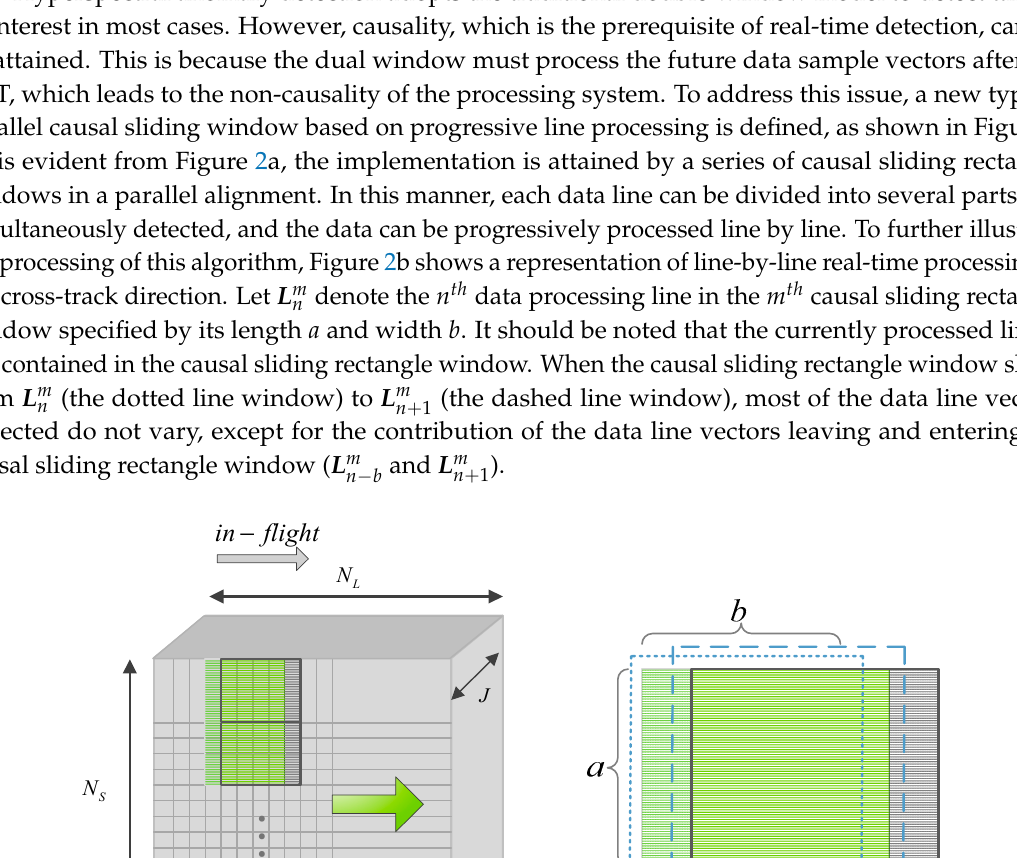
Figure 2. Schematic representation of data acquisition and processing: ( a ) The process of the parallel causal sliding windows; ( b ) The causal sliding rectangle window at L m n and L m